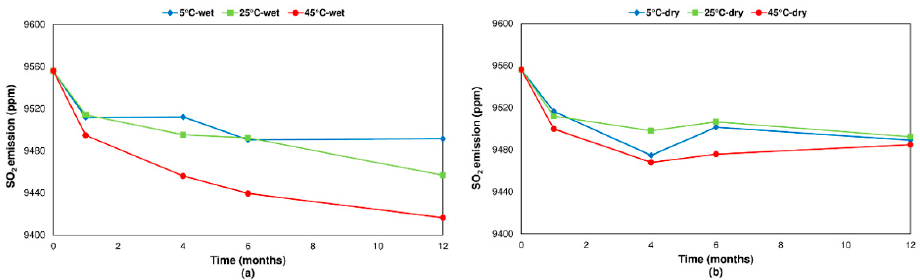
Figure 11. Sulfur dioxide emission area of pyrite (the coarser fraction) at 200–600 ° C in ( a ) a wet environment and ( b ) a dry environment .